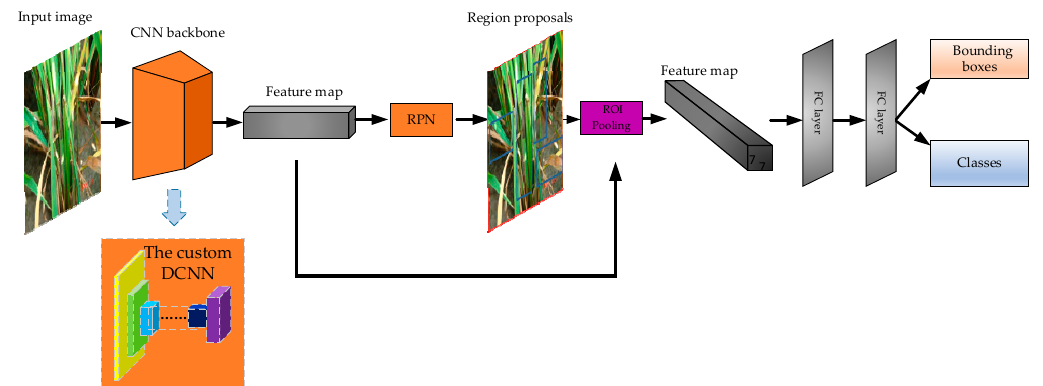
Figure 5. The architecture of the still-image detector, which is using the framework of Faster-RCNN, where the “CNN backbone” is the proposed deep convolutional neural network (DCNN).